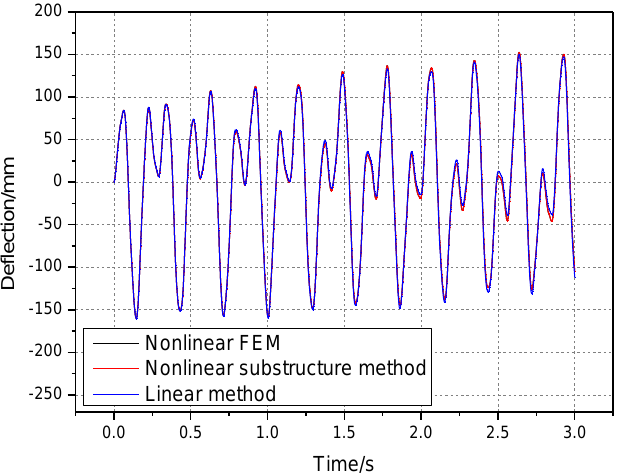
20N F  and 7Hz f  . Figure 14. Dynamic transient analysis results with F = 20 N and f = 7 0 0